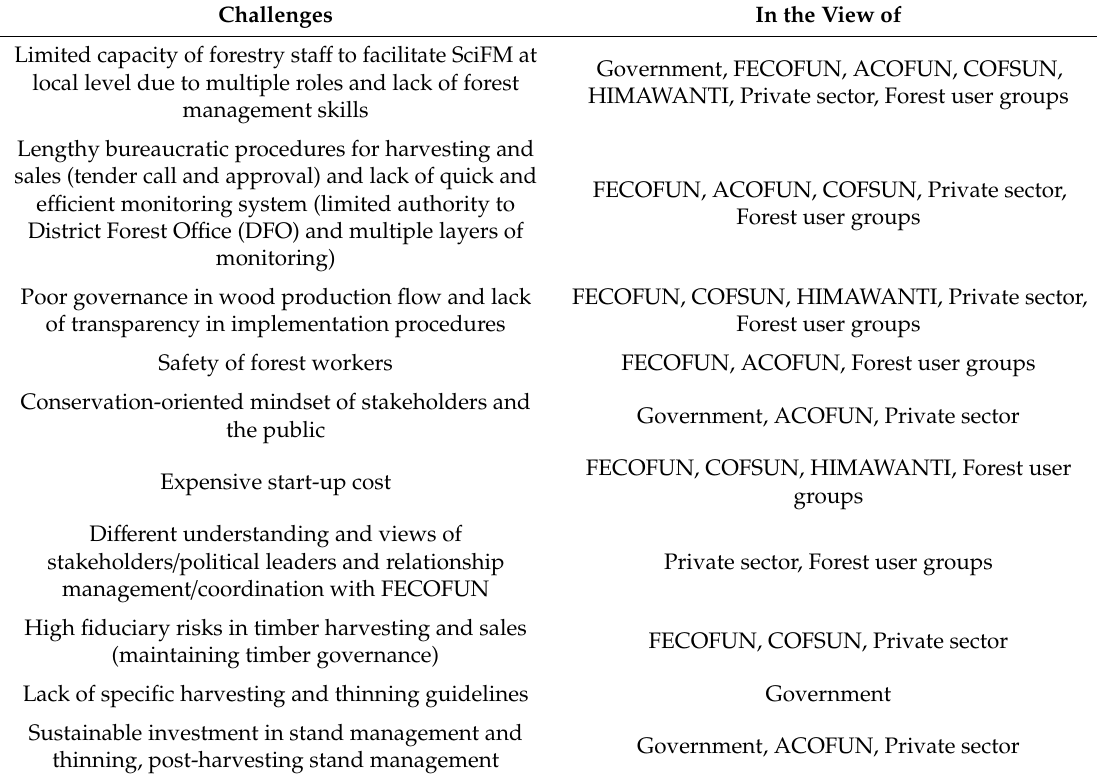
Table 4. Stakeholders’ views on key challenges of SciFM